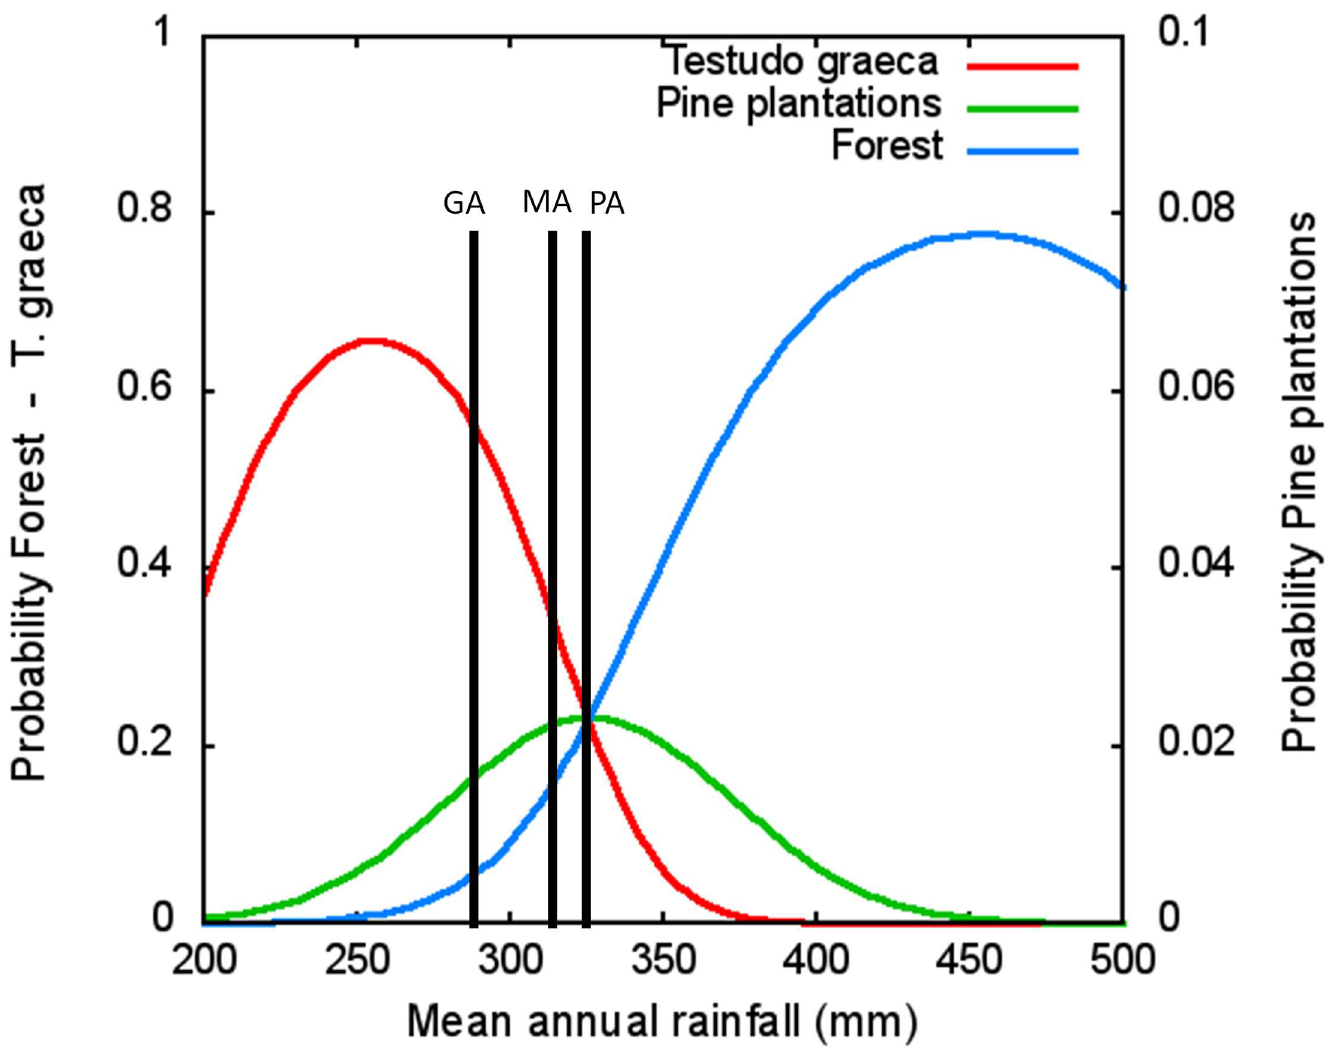
Fig 5. Probability of presenceof natural forests and pine plantations in southeastern Iberian Peninsula [14, 16] and, probability of presenceof T . graeca [33] as a function of mean annual rainfall, according to statiscally significant distribution models. GA, MA and PA sites were represented accordingtheir